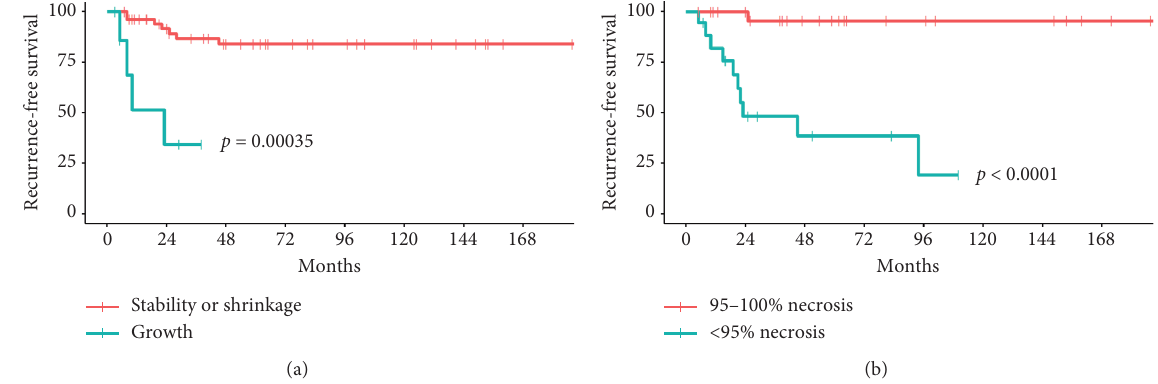
Figure 4: Kaplan–Meier curves of recurrence-free survival in patients with localized Ewing sarcoma stratified by (a) tumor growth vs. tumor stability or shrinkage following NAC and (b) ≥ 95% necrosis vs. < 95% necrosis following Table 2: Patterns of failure and sites of first recurrence in patients with recurrence of initially localized or metastatic Ewing sarcoma. Localized Metastatic Number of patients Lung only Metastatic site(s) at time of diagnosis